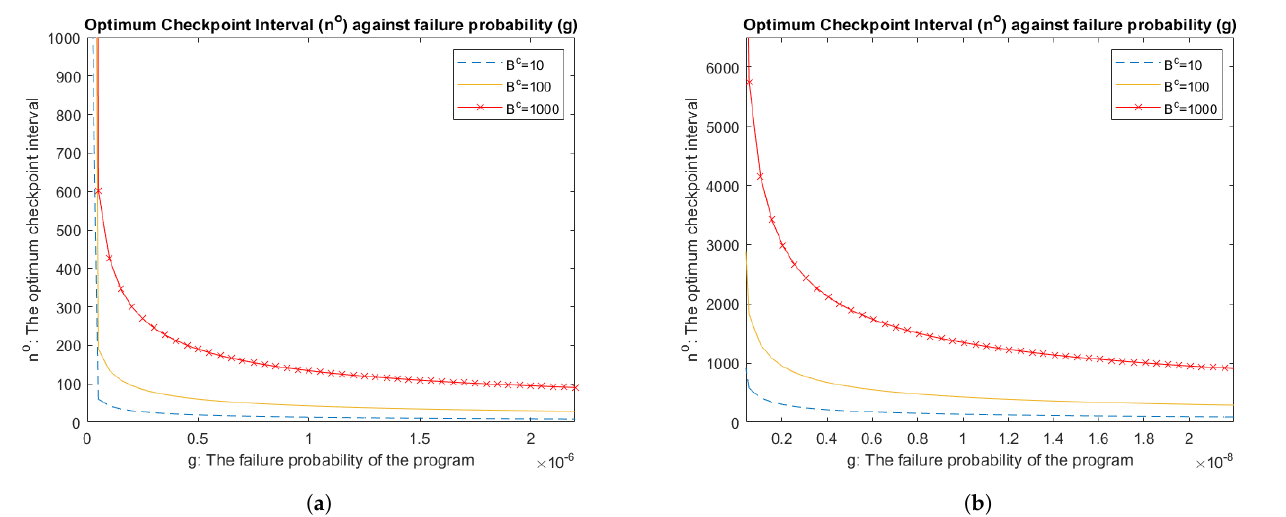
Figure 7. The optimum checkpoint interval n o against the probability of failure g for different cases of checkpointing cost B c , for a large program ( a ) with Y = 10 6 , and a very large program ( b ) with Y = 10 7